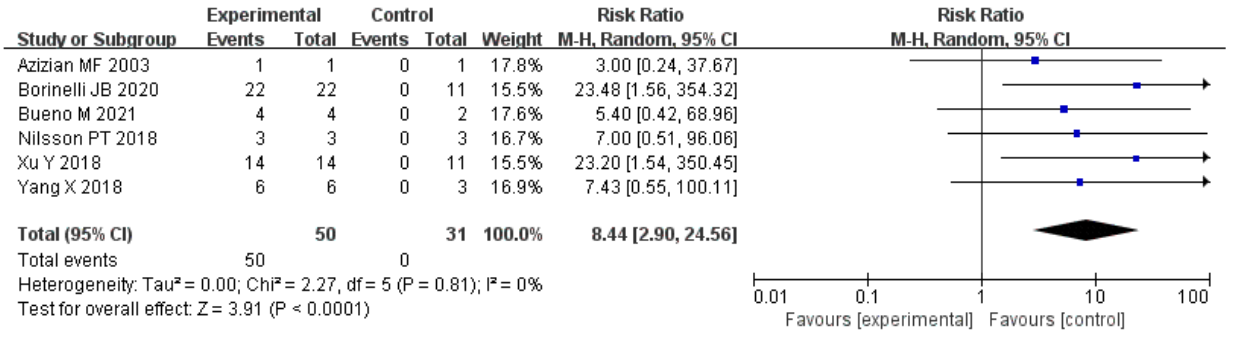
Figure 11. Meta-analysis of benzothiazole and rubber asphalt. The solid horizontal lines indicate the 95% CI. The size of blue squares indicates weight of study in the analysis. The black diamond indicates the pooled odds ratio estimate, with 95% CI represented by the diamond width.